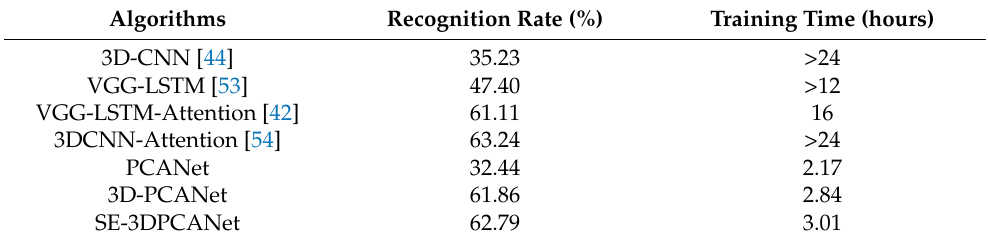
Table 2. Performance comparison of different algorithms on the AFEW dataset.